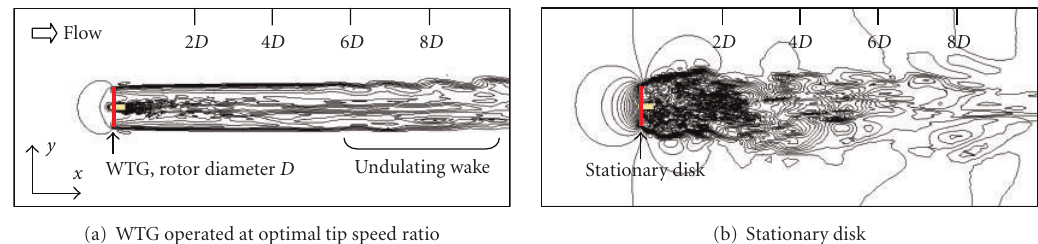
Figure 5: Contour plots of the streamwise ( x ) velocity component, u , with 30 equally spaced contour intervals between u/U = − 0 . 7 and u/U = 1 . 4, instantaneous field, top view of entire domain at z = 0.